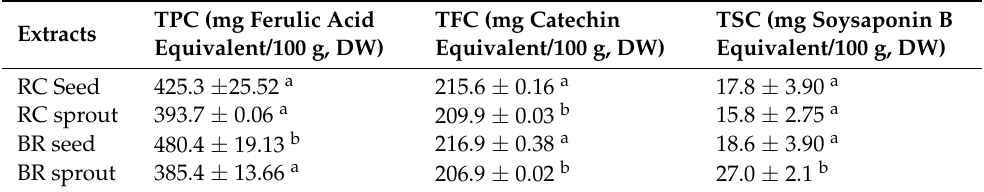
Table 1. Total phenolic content (TPC), total flavonoid content (TFC), and total saponin content (TSC) values of red cabbage and broccoli seeds and sprouts.